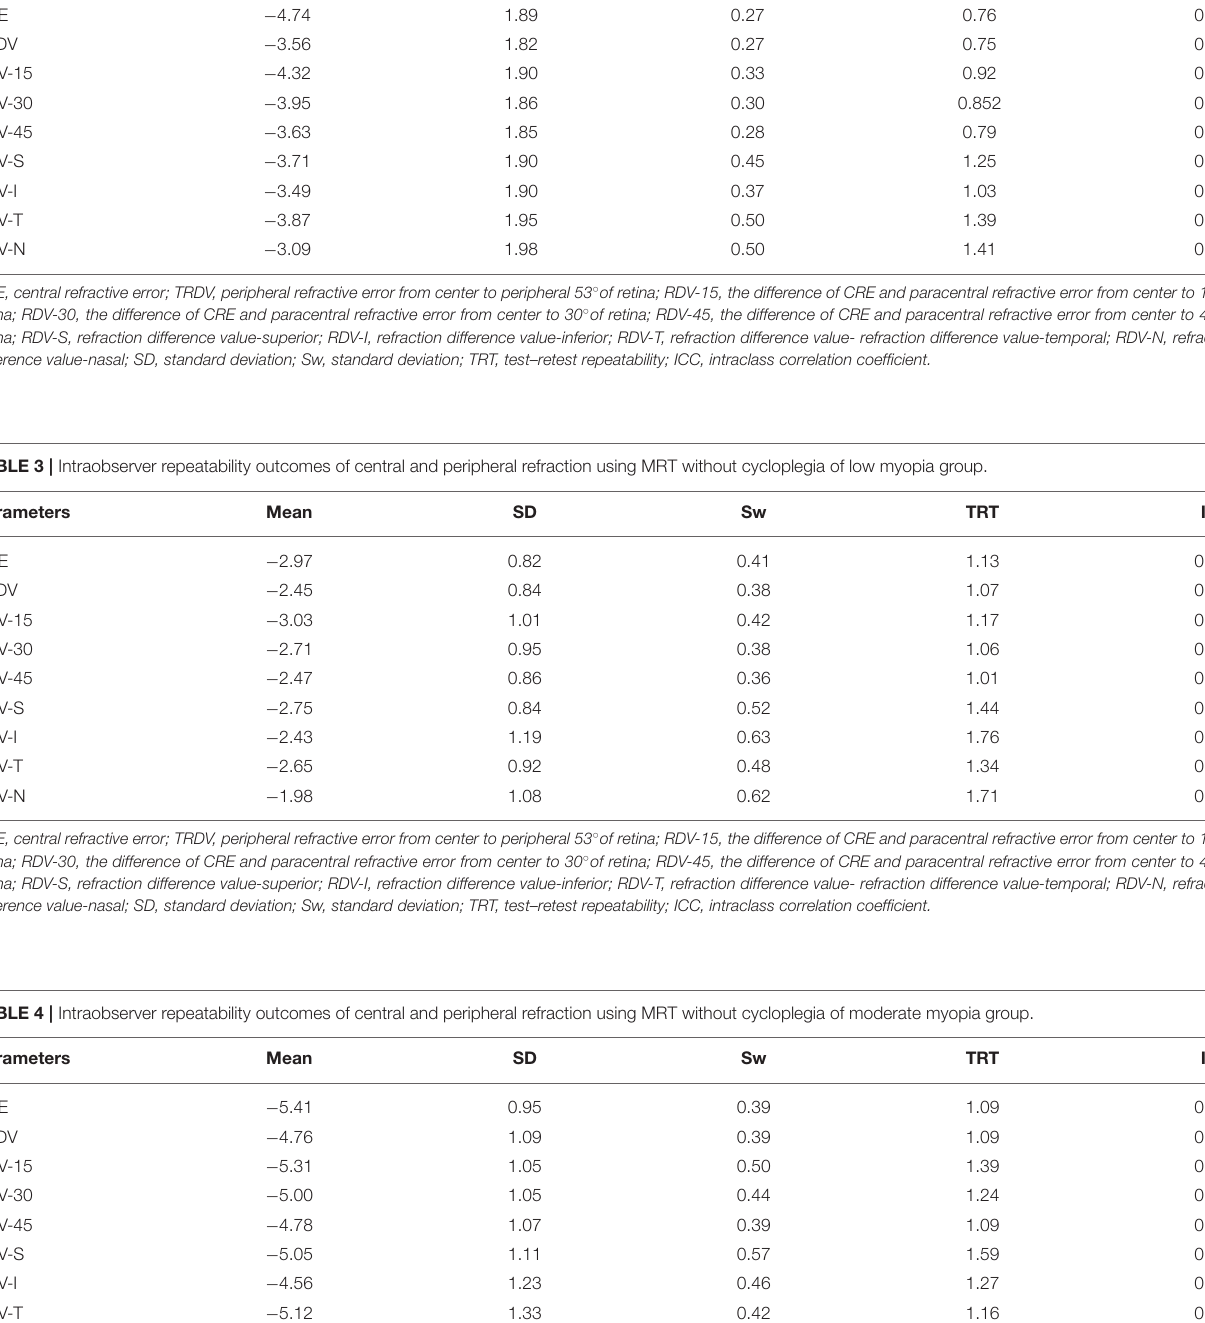
TABLE 2 | Intraobserver repeatability outcomes of central and peripheral refraction using MRT with cycloplegia. Parameters Mean